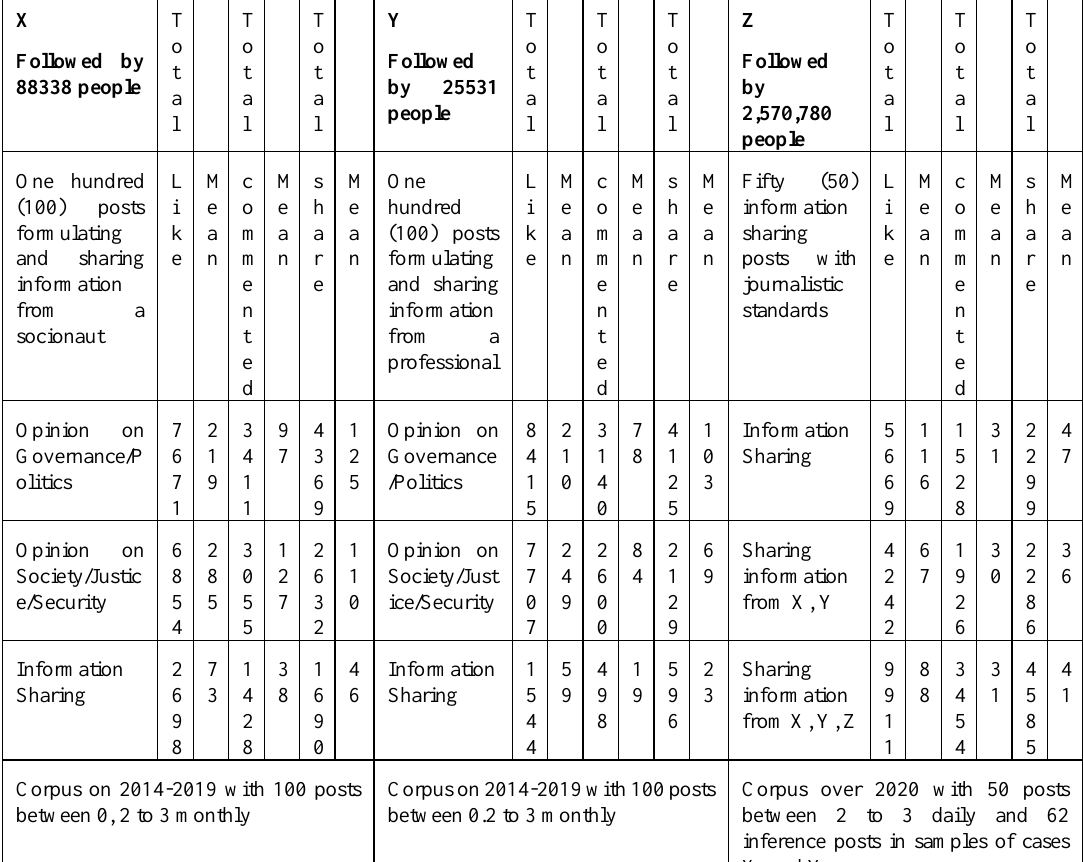
Descriptive table of public behavior with cases X, Y, Z in the formulation of information. Table 1. Puublic behavior with cases X, Y, Z in the formulation of